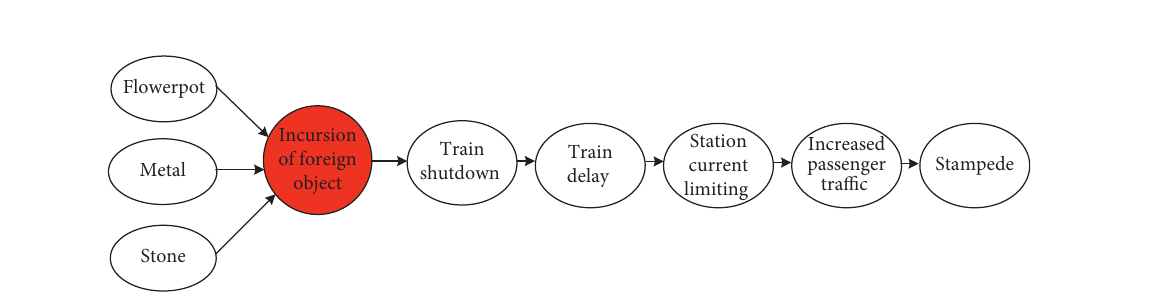
Figure 3: Risk chain for incursion by foreign object.